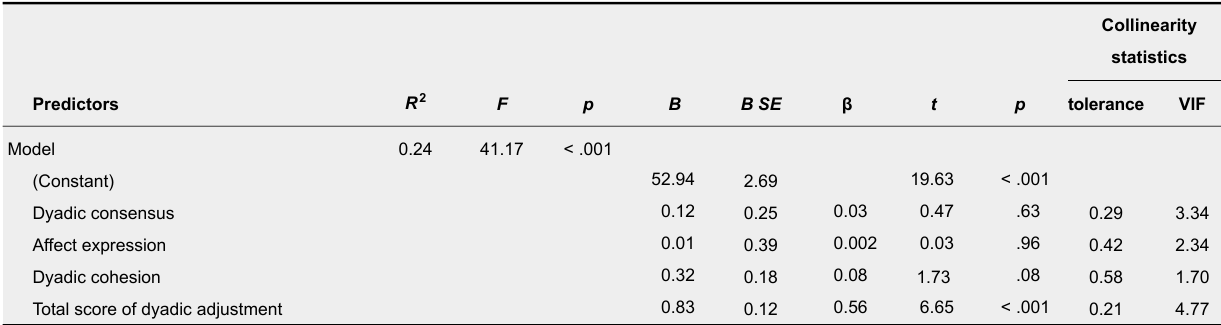
Multiple Regression of Quality of Life on Dyadic